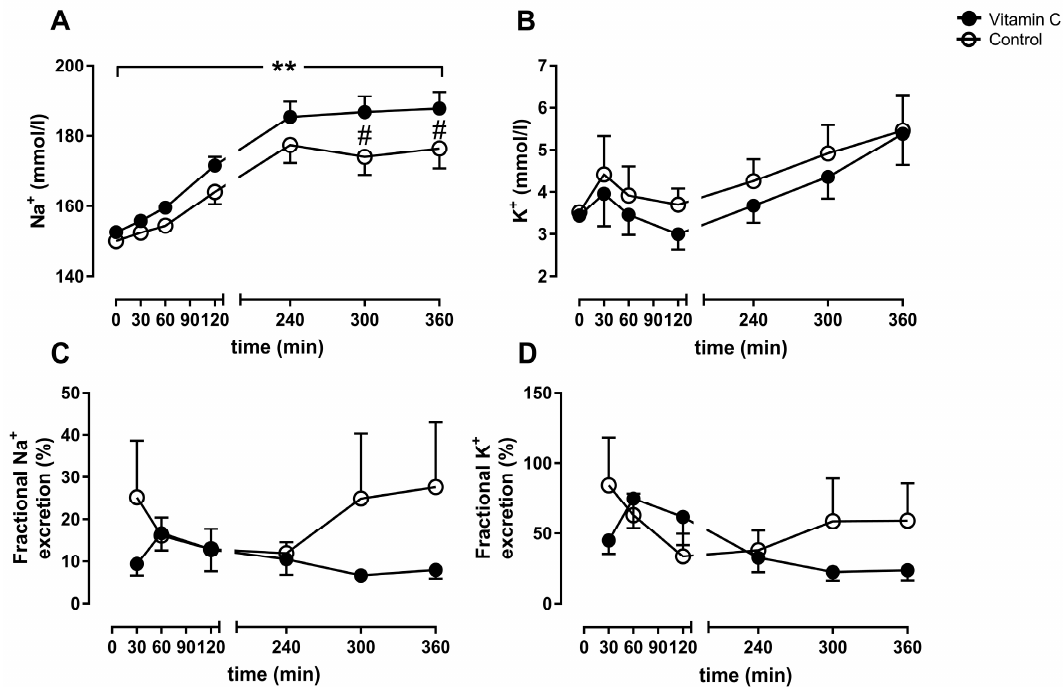
Figure 5. Arterial sodium- (A) and potassium-concentration (B). Fractional sodium- (C) and potassium-excretion (D). ** p < 0.01 effect of time for both groups; # p < 0.05 vs. Control.